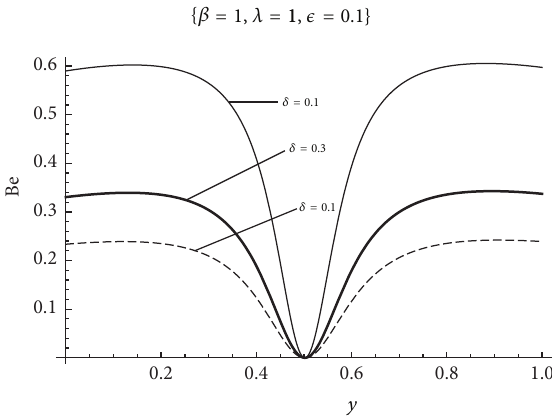
Figure 7: Bejan number at different Frank-Kamenetskii parameter.